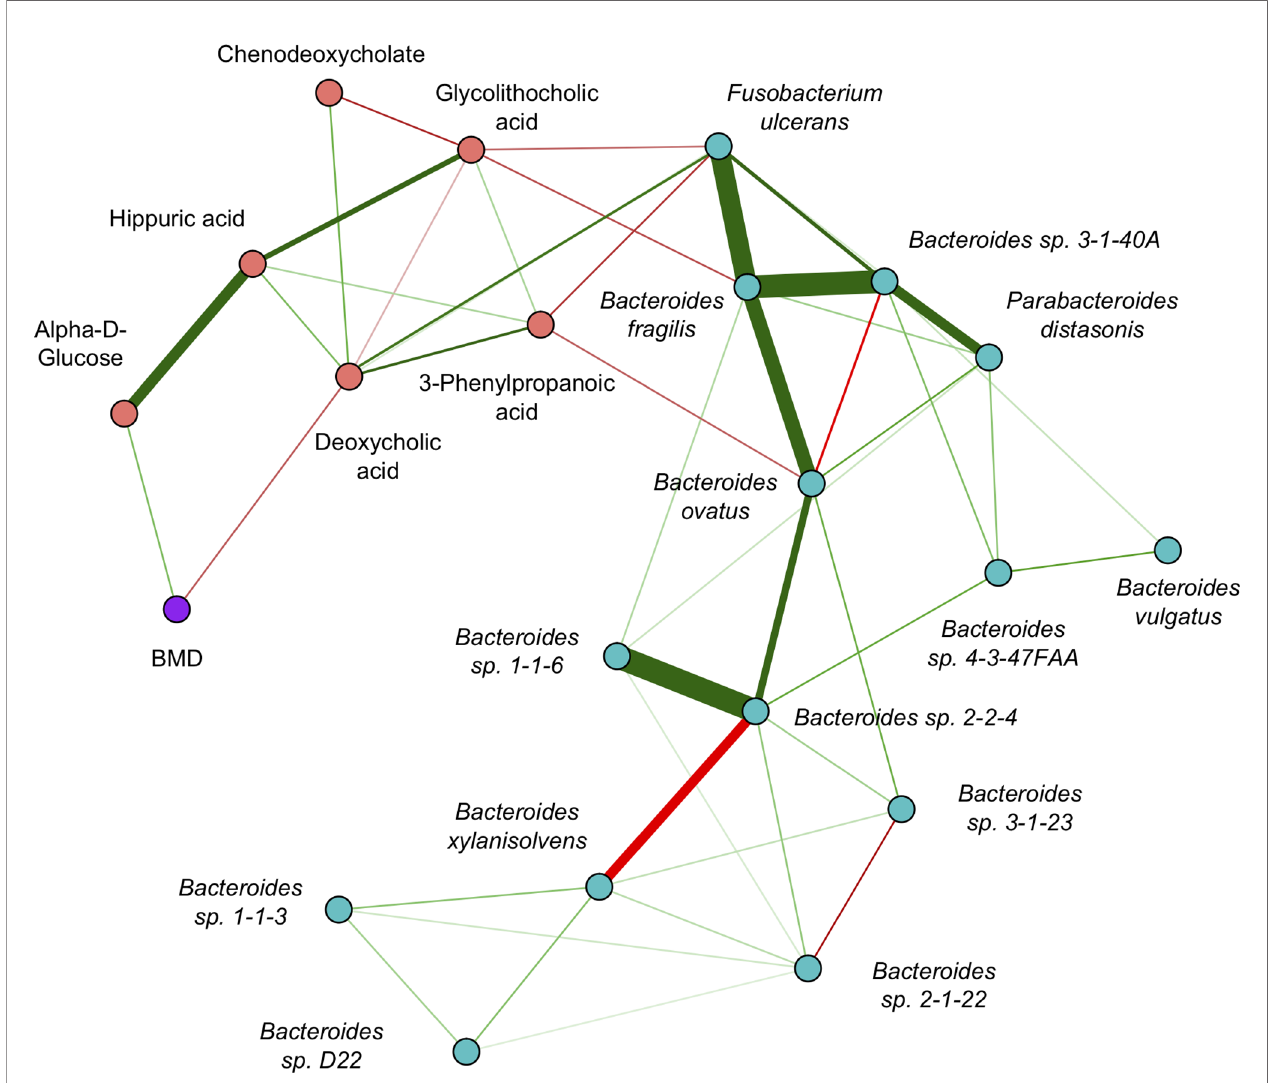
FIGURE 5 | Inter-omics Gaussian graphical model for sCCA selected features. The edges represent partial correlations, and signi fi cant edges were selected by the graph lasso penalty. Blue/red nodes correspond to microbe/metabolite features, BMD is shown in purple, and green/red edges correspond to positive/negative partial correlations. The edge width indicates the strength of